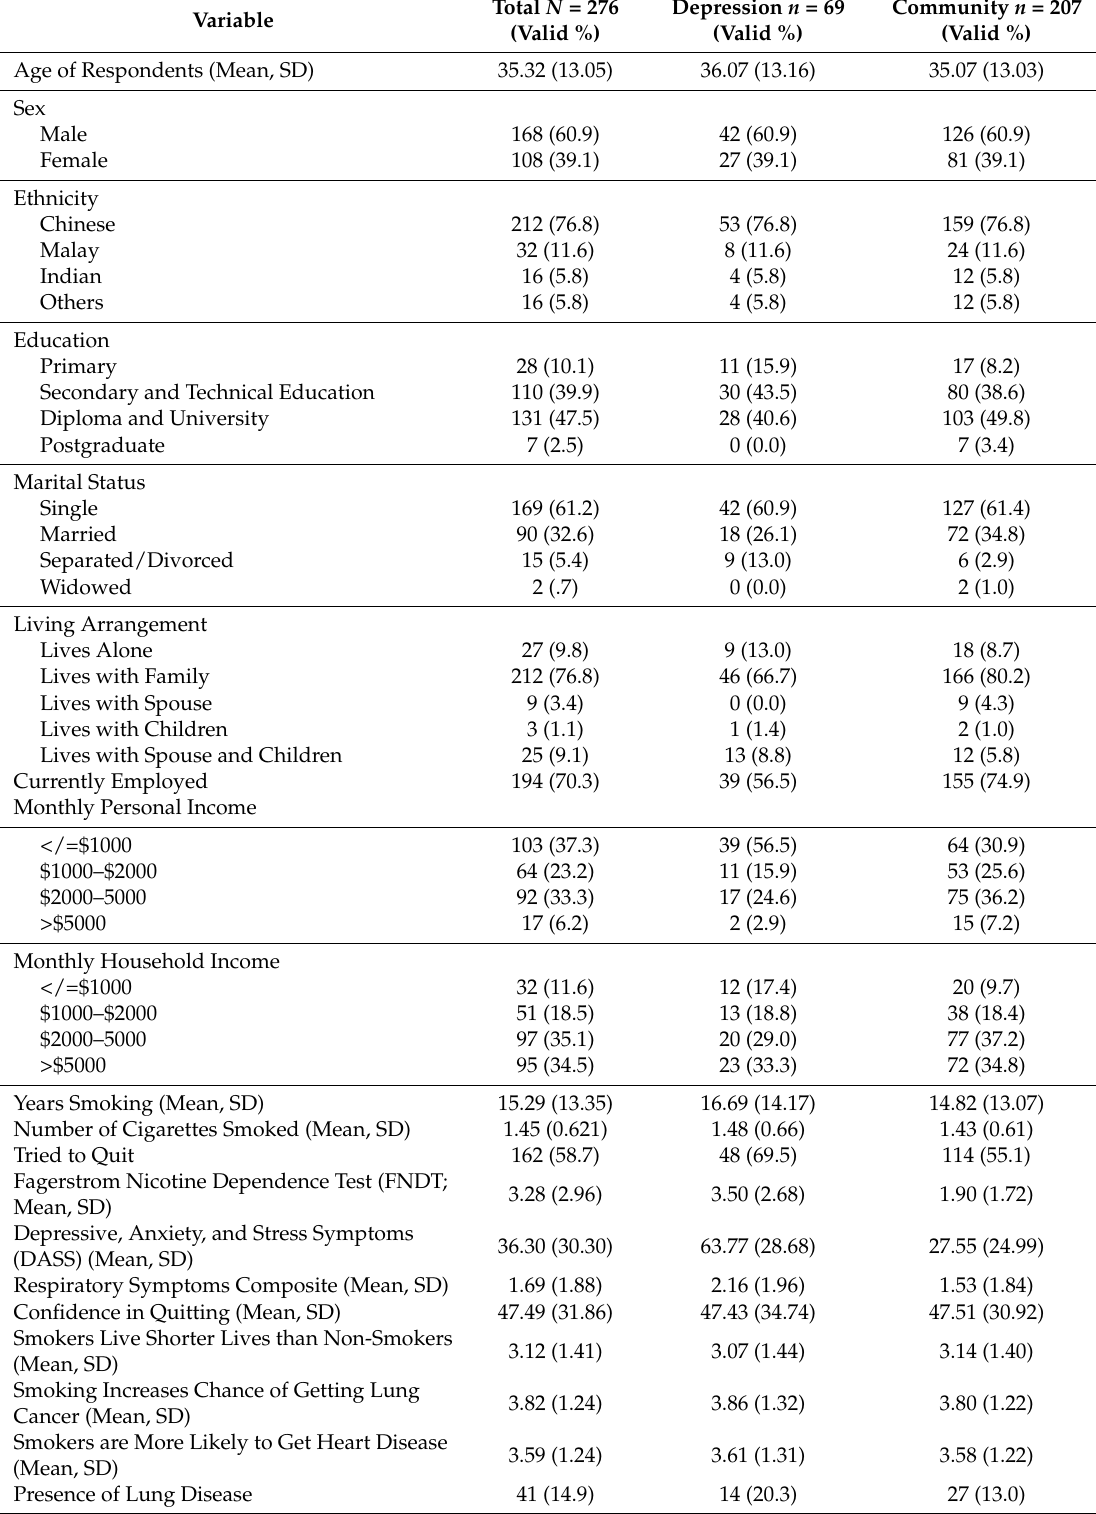
Table 1. Profiles of Respondents ( N = 276) (Cases Matched